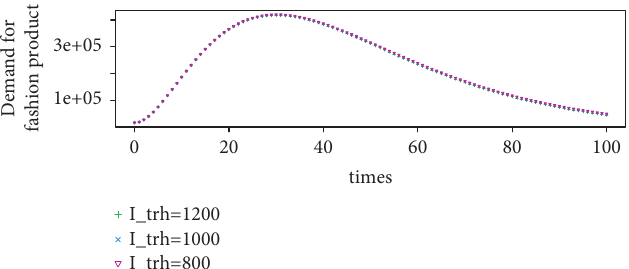
. Threshold of government policy trh